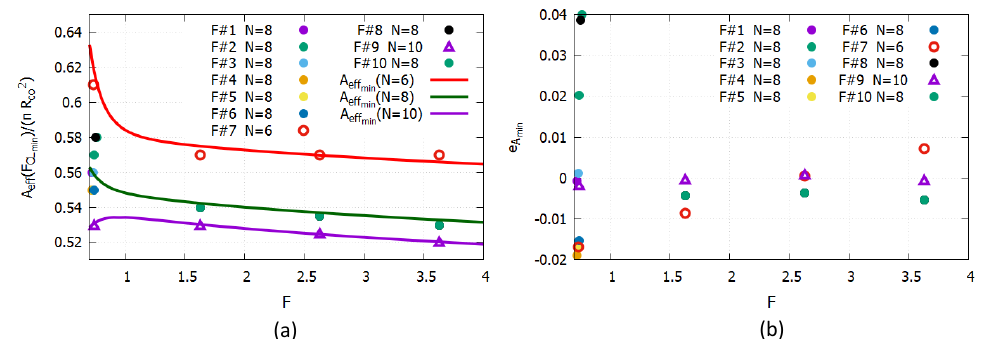
Figure 8. ( a ): Effective area normalized to π R 2 co , calculated at the normalized frequencies of the CL minima. ( b ): Relative error e A of Equation (19) with respect to numerical results of A ef f ( F CL min Filled dots refer to numerical results for fibers with N = 8, red empty circles to N = 6 and violet triangles to N = 10. Solid curves refer to results from Equation (8) with N = 6 (red), N = 8 (green), and N = 10